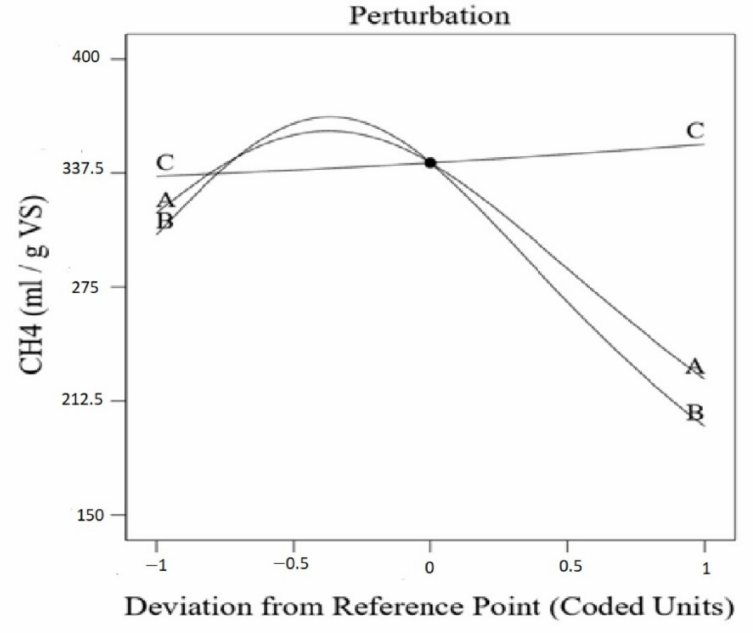
Figure 3. Effects of pretreatment temperature; (A) NaOH concentration (B) and H 2 O 2 concentration (C) on the biogas production at the central